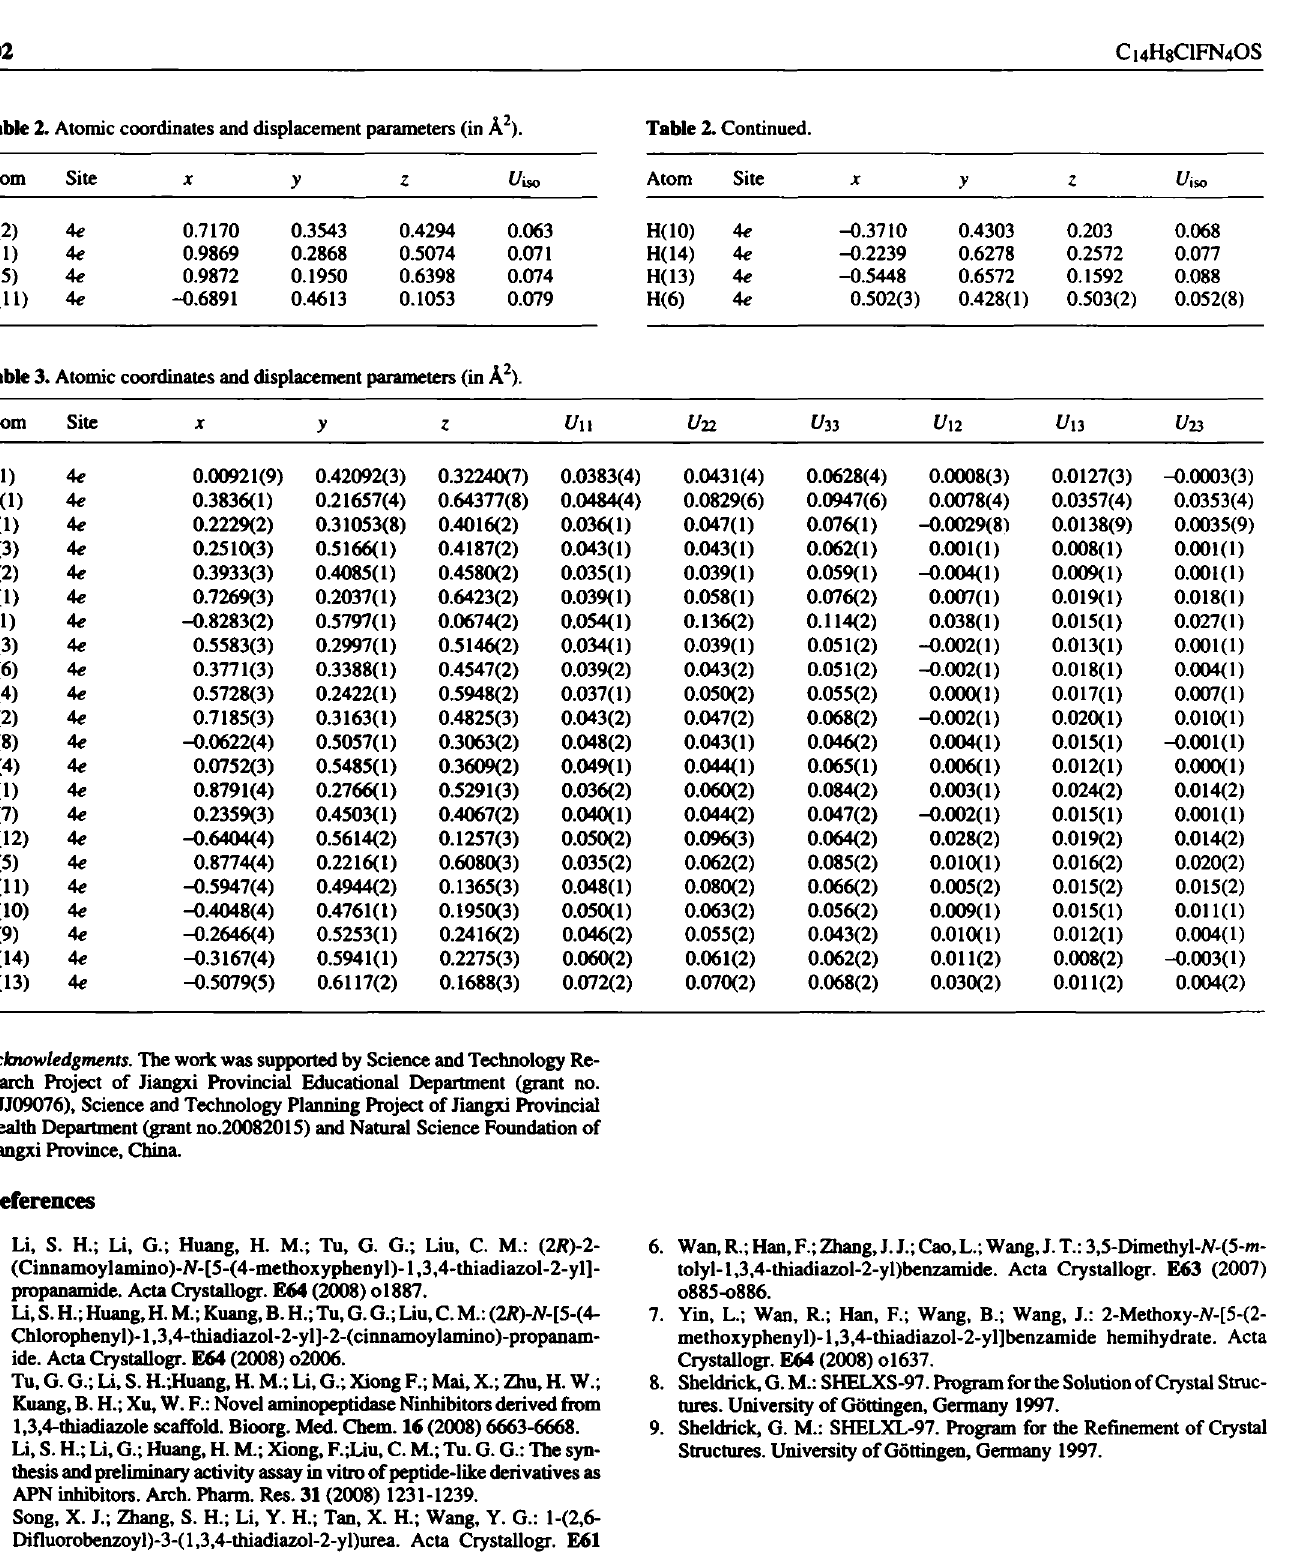
Table 2. Atomic coordinates and displacement parameters (in À 2 ). Table 2. Continued.